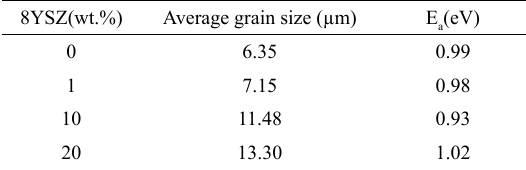
Table 2. Values of average grain size and apparent activation energy (E ) for conduction of solid electrolytes sintered at 1450 ºC for 4 h. a